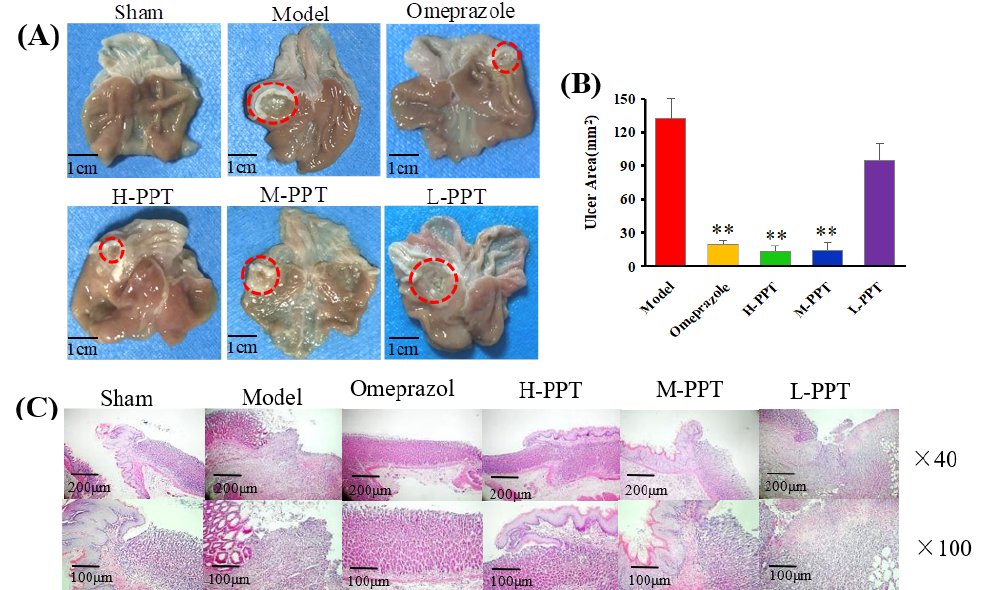
Figure 2. Macroscopic and microscopic pictures of the stomachs of all groups demonstrated the validity of the model employed. ( A ) The macroscopic images of stomachs from all groups. The red circle indicates ulcer location. Scale bar = 1 cm. ( B ) The ulcer areas of different groups (compared with the model group, ** p < 0.01). ( C ) Hematoxylin and eosin (H&E) staining of the gastric mucosa.